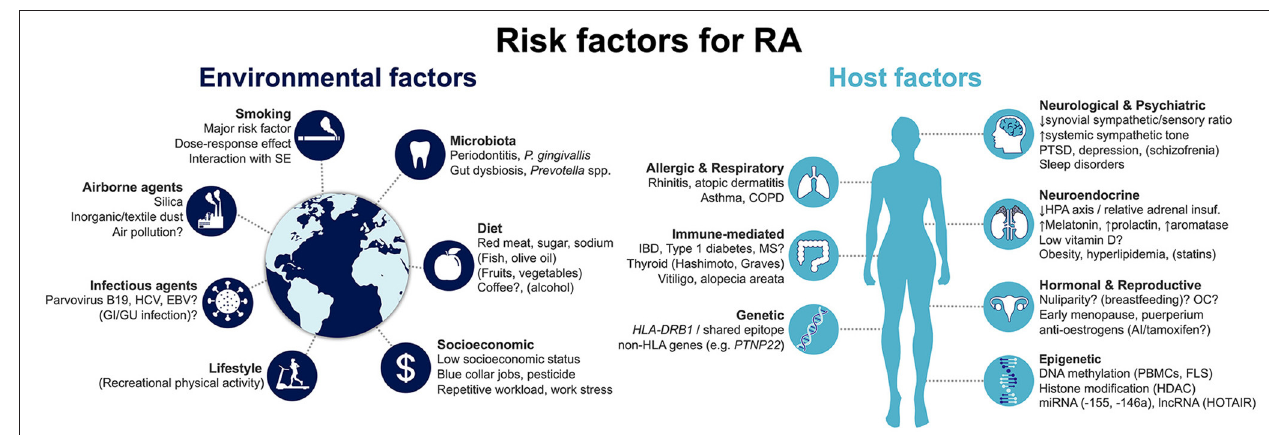
FIGURE 1 | Summary of risk factors for the development of rheumatoid arthritis. Factors that are associated with decreased risk are represented in brackets. Factors for which evidence is conflicting and uncertainty remains are followed by a question mark. AI, aromatase inhibitors; COPD, chronic obstructive pulmonary disease; EBV, Epstein-Barr virus; FLS, fibroblast-like synoviocyte: GI, gastrointestinal; GU, genitourinary; HCV, hepatitis C virus; HDAC, histone deacetylases; HLA, human leukocyte antigen; HPA, hypothalamic-pituitary-adrenal; IBD, inflammatory bowel disease; lncRNA, long non-coding RNA; miRNA, micro RNA; MS, multiple sclerosis; OC, oral contraceptives; PBMCs, peripheral blood mononuclear cells; PTSD, post-traumatic stress disorder; SE, shared